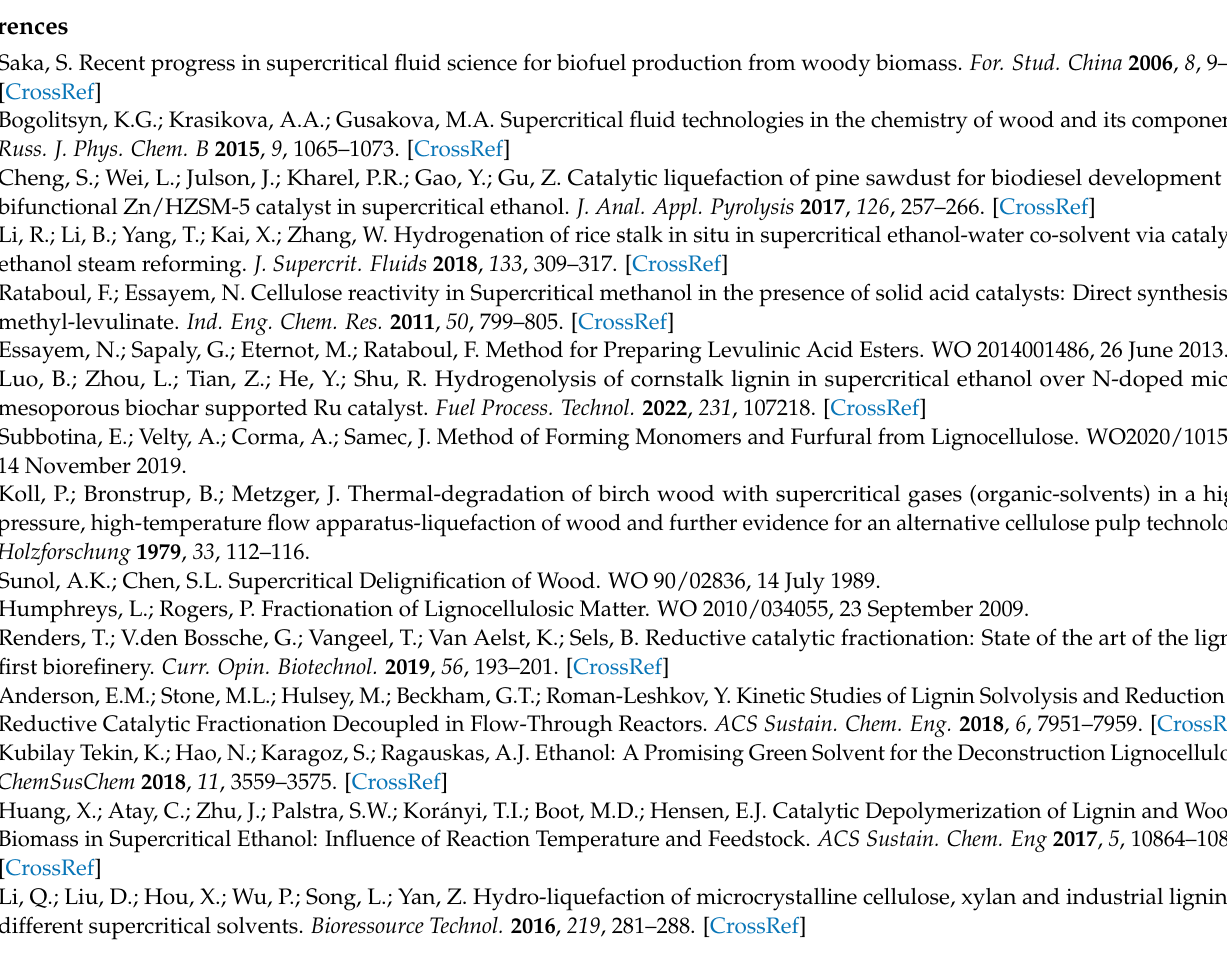
Light liquid products; Figure S1: XRD Pattern of ZrO 2 /La 2 O 3 ; Figure S2: XRD pattern of CuZnAlO; Table S1: Fresh catalysts and solid residues calcined atat 1000 ◦ C under air in a muffle furnace: remaining weights on catalyst basis (wt%); Table S2: Table of identified products corresponding to the chromatogram shown in Graph S1; Table S3: Relative coefficients with respect to dodecane calibrated for the main